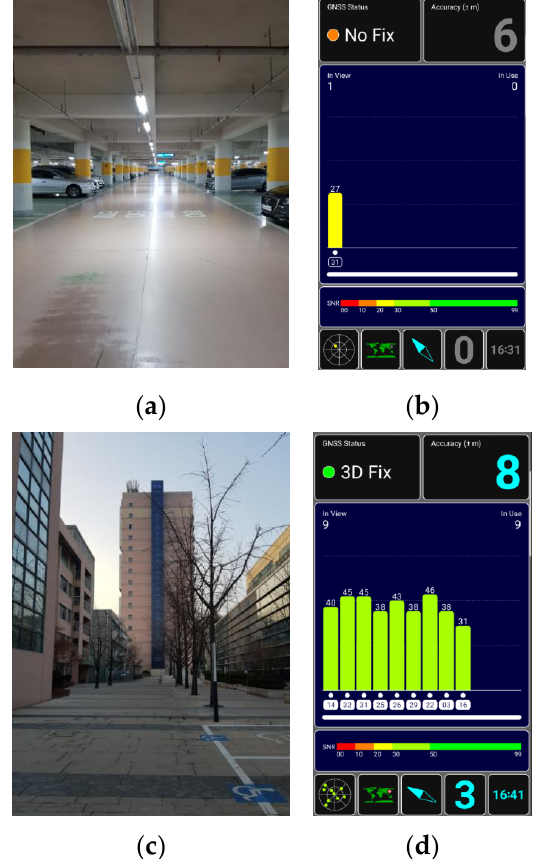
Figure 9. Data collected similar to a traffic environment: ( a ) underground parking, ( b ) corresponding GPS signal, ( c ) outdoor environment, ( d ) corresponding GPS signal.